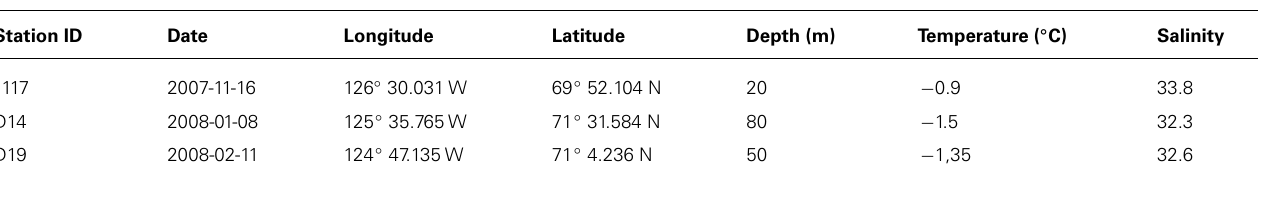
Table 1 | Position of sampling stations and environmental characteristics of the water used for BrdU